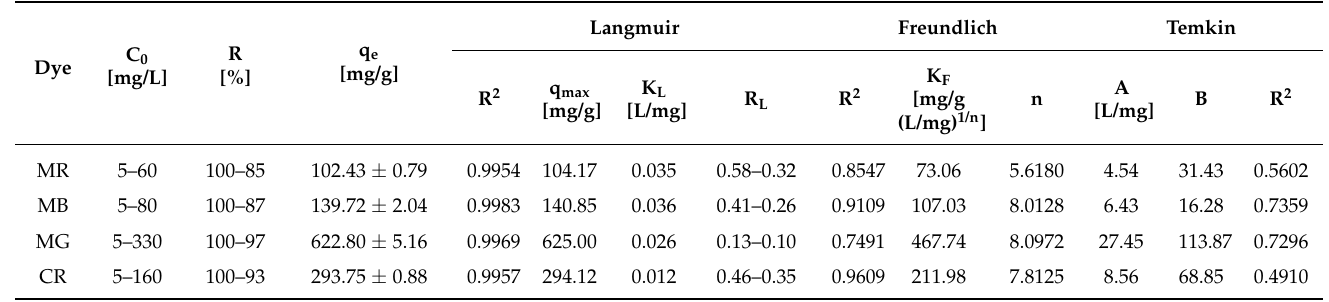
Table 4. Langmuir, Freundlich and Temkin parameters of the adsorption isotherms of organic dyes onto activated carbon—PC5A8.